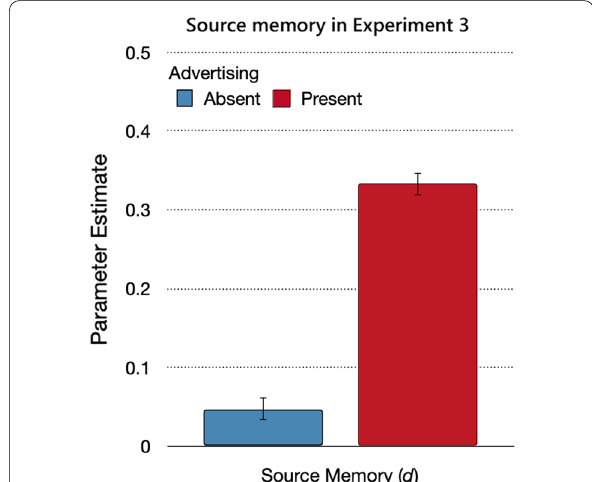
Fig. 8 Source memory in Experiment 3. Note : Parameter estimates of the source memory parameter d , reflecting the probability of correctly remembering the source of the statements from the trustworthy and advertising sources. The error bars reflect standard errors